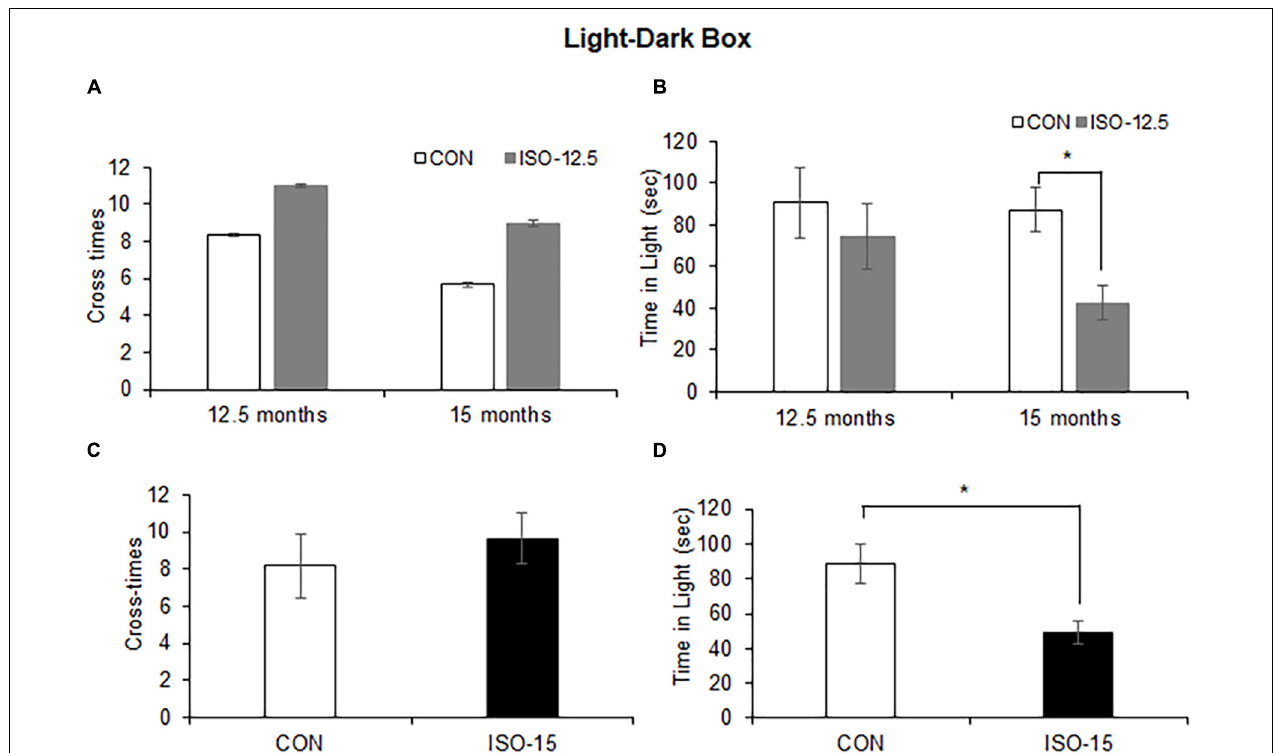
FIGURE 2 | Anxiety was shown in isoflurane-exposed old mice ( n = 10). (A) The cross-time differences between the ISO-12.5 group and the CON group were not significant at age of 12.5 or 15 months. (B) The time stayed in the light box revealed not significant difference between the ISO-12.5 group and the CON group; however, a significant reduction of time stayed in the light box was shown in the ISO-12.5 group when these mice were at the age of 15 months (* p < 0.05). (C) The cross-time difference between the ISO-15 group and the CON group were not significant. (D) The time stayed in the light box was significantly reduced in the ISO-15 group compared with the CON group (* p <